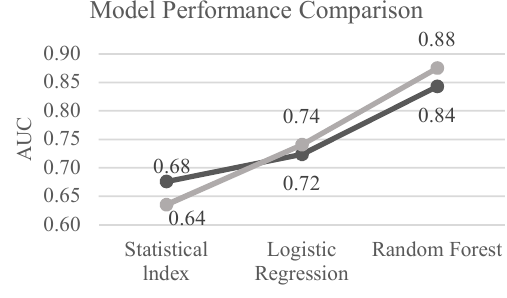
Figure 8. Average Model Fit Performance